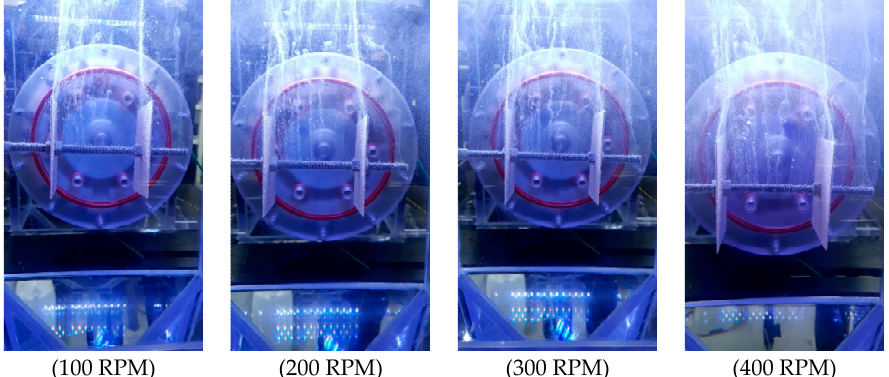
Figure 6. Speed vs. voltage drop.